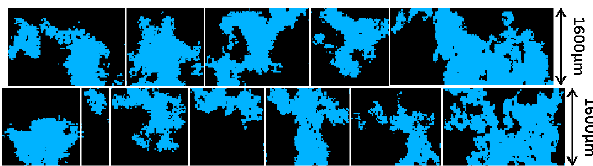
Fig. 15. Examples of CIP shadow images as observed at roughly 6km altitude during the 16 August flight.